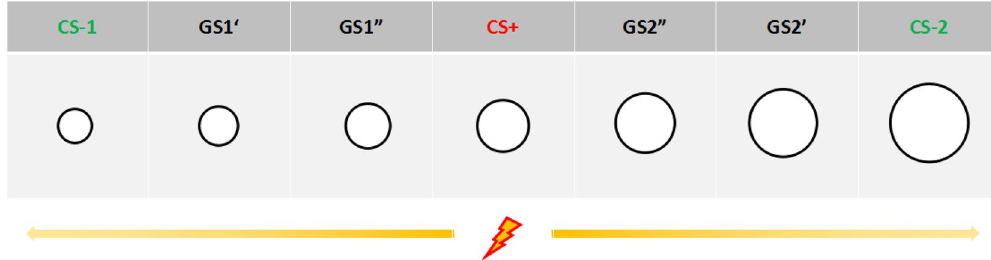
Figure 1. Experimental material: CS (conditioned stimuli).